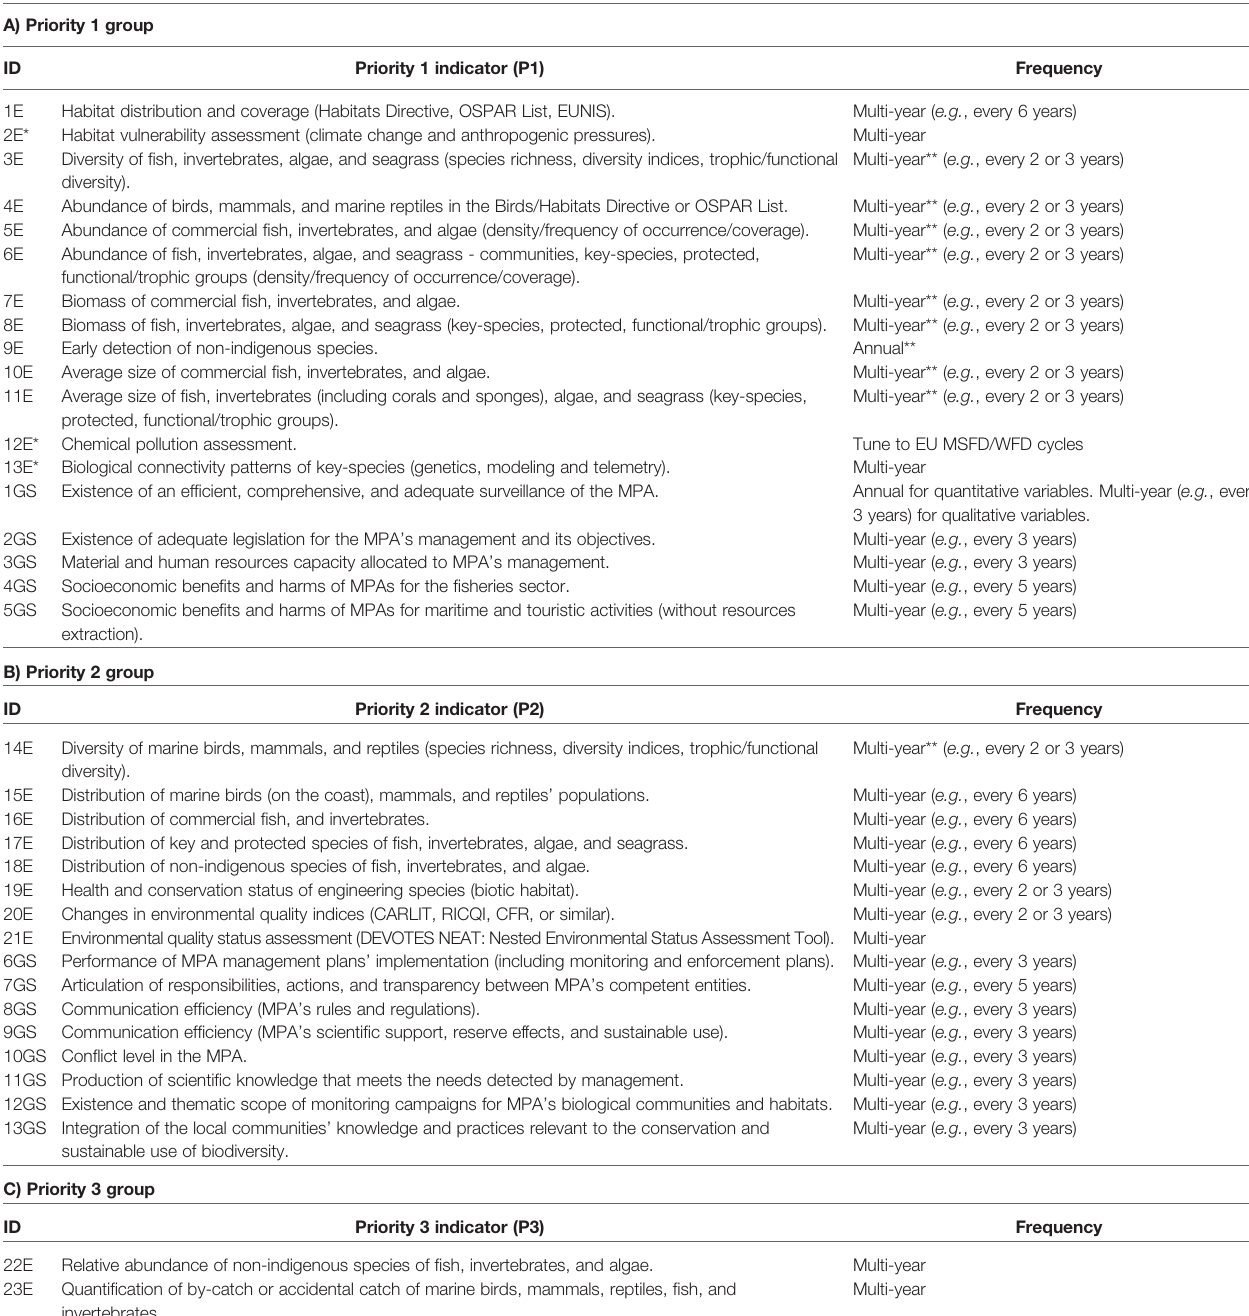
TABLE 3 | Shortlist of performance indicators for Portuguese mainland MPAs grouped by priority level and their minimum monitoring frequencies or reporting frequencies for environmental, governance and socioeconomic